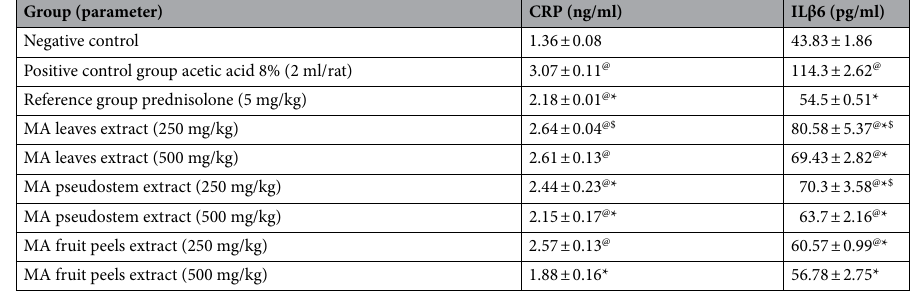
Table 7. CRP and ILβ6 anti-inflammatory activity of MA leaves, pseudo-stem and fruit peels. Results are expressed as mean of levels of CRP and IL β6 ± S.E in serum of rats treated with MA leaves ,pseudo-stem and fruit peels (250 and 500 mg/kg) and Prednisolone (5 mg /kg) for two successive weeks followed by induction of colon lesions by using acetic acid 8%(2 ml/rat); n = 8; Data were analysed using one way analysis of variance (ANOVA) followed by Tukey Kramer’s multiple comparisons test; Significant at P ≤ 0.0001. @ Significant different from negative control; *Significant difference from positive control group; $ Significant difference from prednisolone